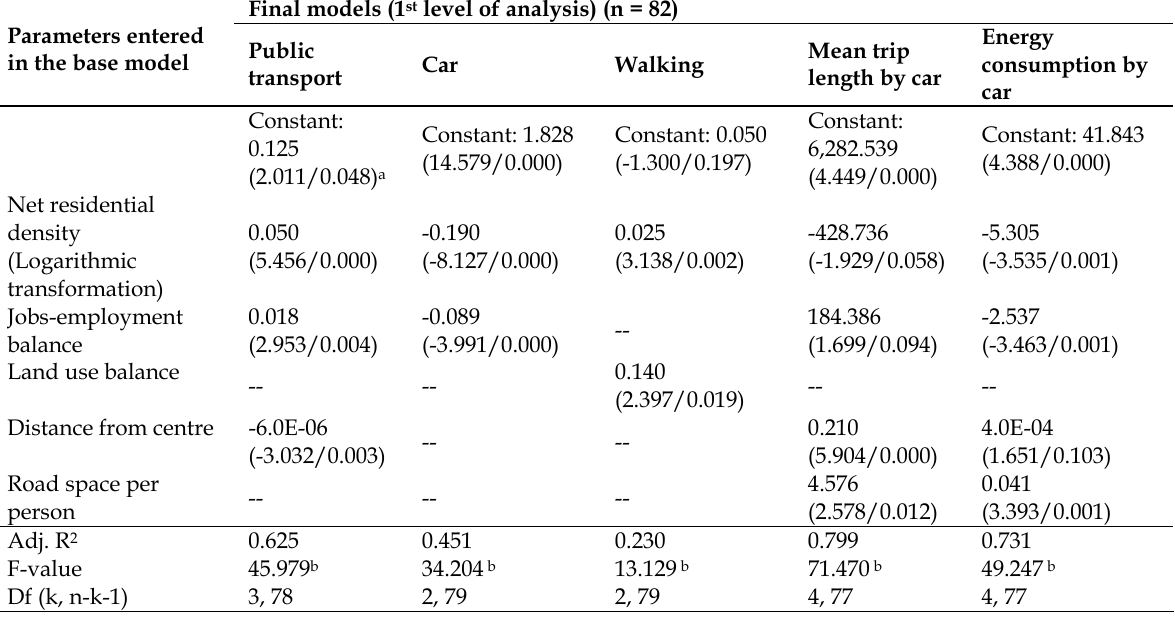
Table 3. The most crucial characteristics of urban form affecting travel behaviour in